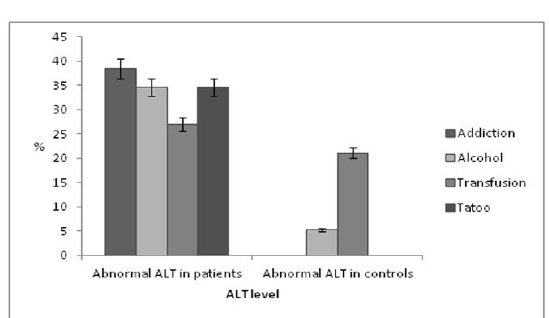
Figure 3. The Relationship between Alanine Aminotransferase Levels in the Controls and Patients and Common Risk Factors of Hepatitis C Virus Infection. ALT: alanine